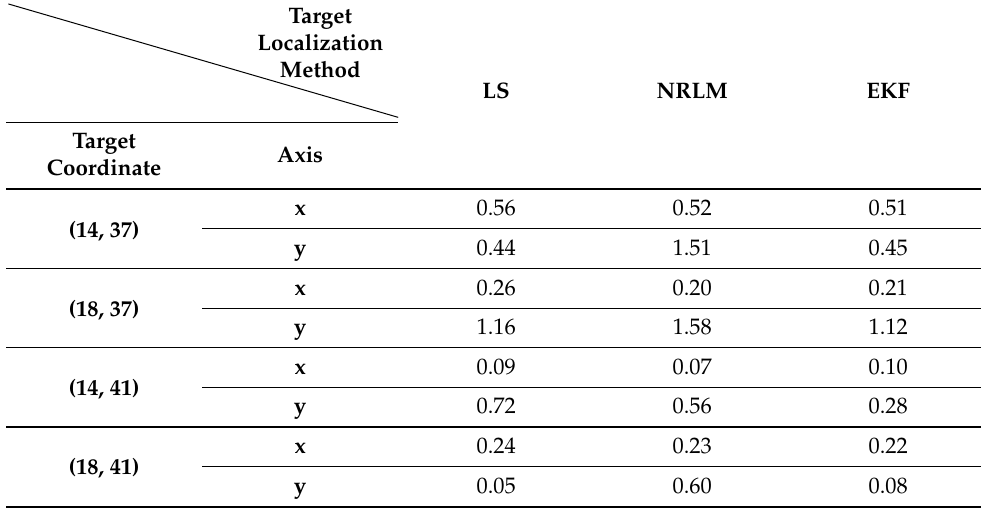
Table 1. Case 1—RMSE of target coordinates ( X, Y ) for the marker pen (unit: cm).